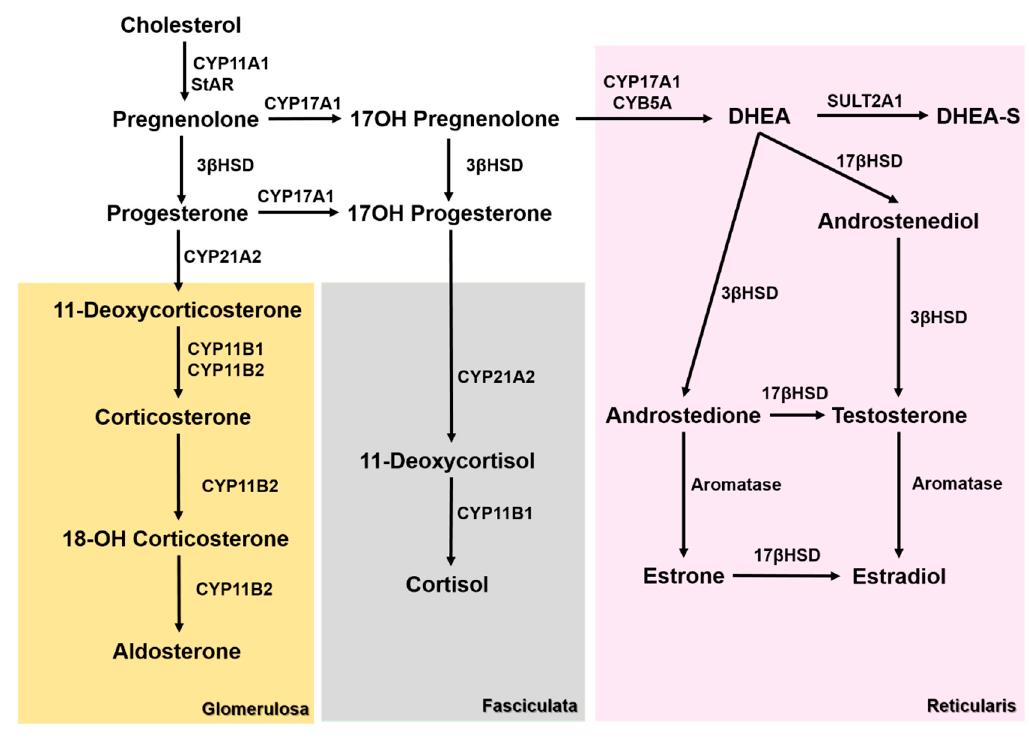
Figure 1. Steroidogenesis pathways in the different adrenal cortex layers. 3 β HSD—3 β -hydroxysteroid dehydrogenase, 17 β HSD—17 β -hydroxysteroid dehydrogenase, CYB5A—Cytochrome B5A, CYP11A1— cholesterol side chain cleavage enzyme, CYP11B1—11 β -hydroxylase, CYP11B2—aldosterone synthase, CYP17A1—17 α -Hydroxylase, CYP21A2—21 α -hydroxylase, dehydroepiandrosterone (DHEA), dehydroepiandrosterone sulfate (DHEA-S), StAR—steroidogenic acute regulatory